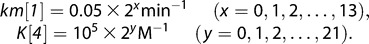
Stochastic Simulation of the Heat Shock Response(A) Stochastic realization of the concentration of DnaK at low temperature for the wild-type and the DEG-FB mutant. The average concentration of σ32 and DnaK are constrained to be equal in wild-type and mutant. In the wild-type (bold line): K[4] = 5.12 × 107 M−1, km[1] = 3.2 min−1
K[5] = K[6] = 1 × 108 M−1, kx[1] = kx[2] = 5 min−1, η = 1. In the DEG-FB mutant (thin line): K[4] = 5.12 × 107 M−1, km[1] = 0.1 min−1
K[5] = K[6] = 0 M−1, kx[1] = kx[2] = 0 min−1, η = 1.(B) The CV of DnaK is plotted as a function of total σ32 concentration for the wild-type (SEQ+DEG+FF system) (▵) and the DEG-FB knockout mutant (SEQ+FF) (○). The plot reports the CV for the parameter values that satisfy the required yield (>0.9) and efficiency (>0.85). Yield and efficiency are computed by searching the 2-D parameter space consisting of the transcription rate constant for σ32 and the association constant between σ32 and DnaK as follows,